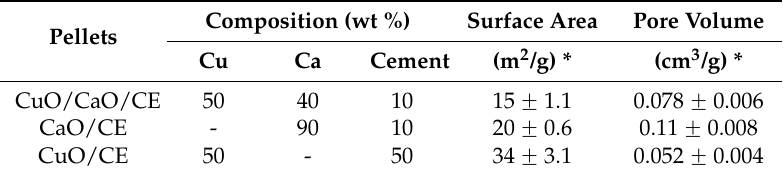
Table 1. Composition, surface area and pore volume of the three types of